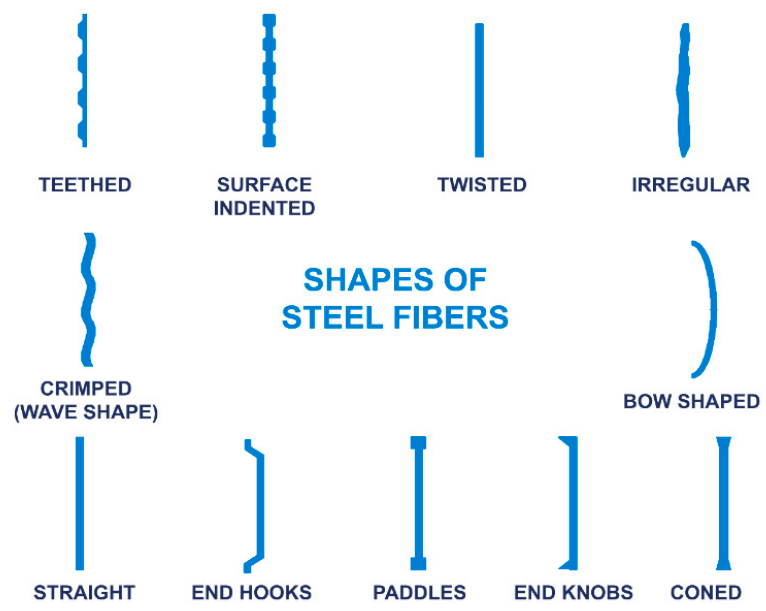
Figure 2. Different shapes of steel fibers.